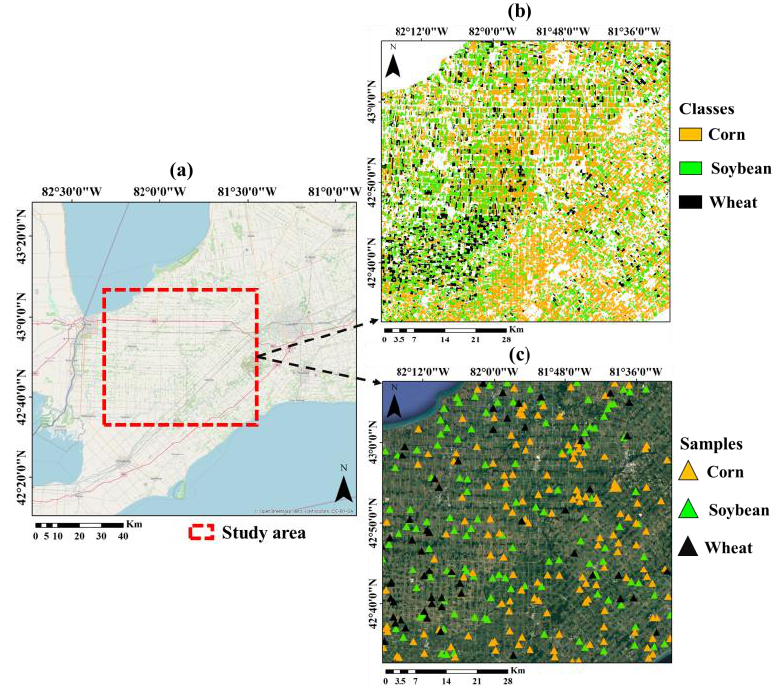
Figure 1. Maps of ( a ) the geographical location of the study area, ( b ) the land crop classes of the study area and ( c ) the geographical location and spatial distribution of RCF samples of different land crops.